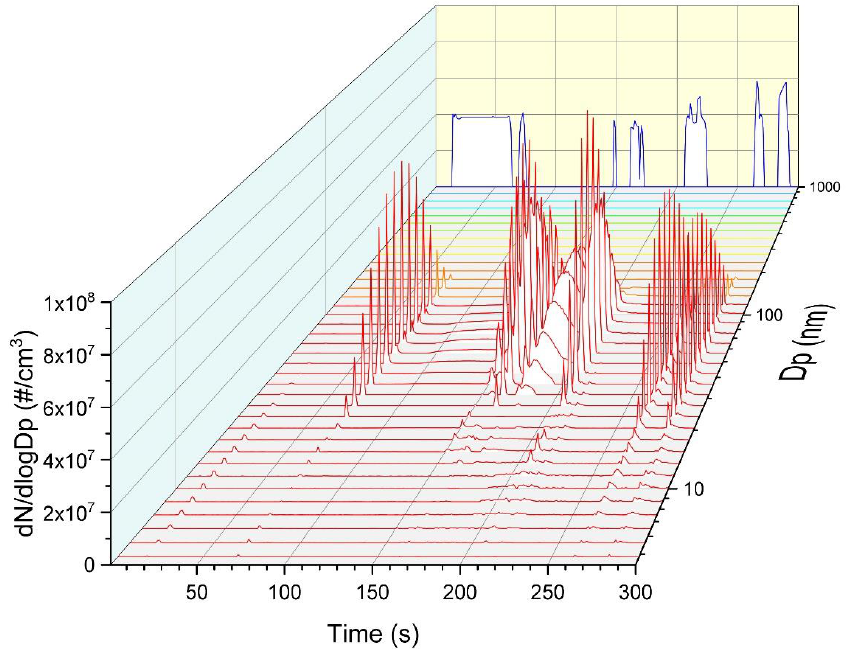
Figure 19. Transient PNSD over the first 300s of a warm start WLTC. Engine RPM is indicated qualitatively in blue on the back wall.